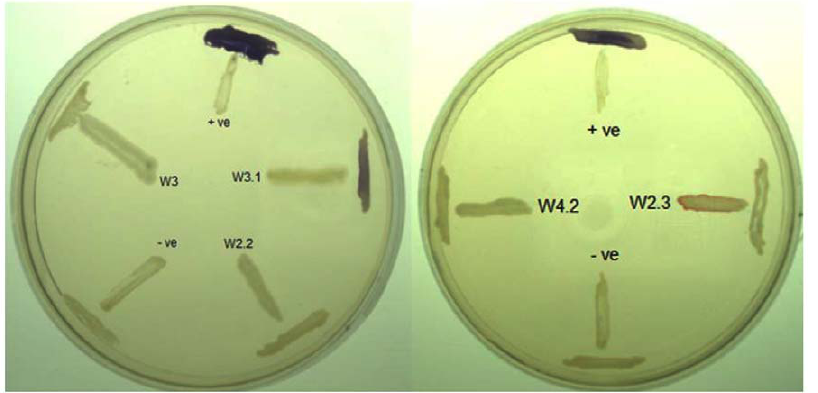
Figure 3. Screening of AHL production using Chromobacteriumviolaceum CV026 as biosensor. The test strains were cross-streaked against CV026. The positive control ( + ve) strain is E. carotovora GS101 and the negative control ( 2 ve) strain is E. carotovora PNP22 (AHL synthase deficient mutant). Only W3.1 isolate showed positive response.